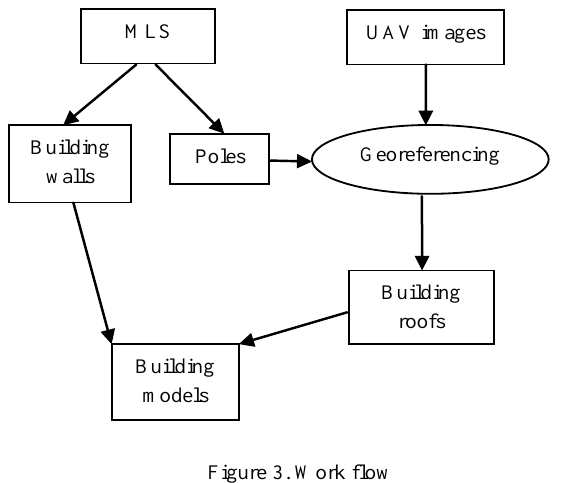
Figure 3. Work flow